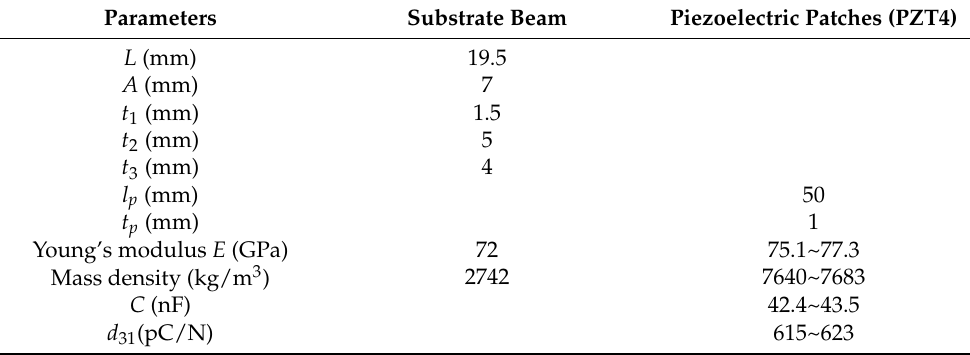
Table 1. Dimensions and physical parameters of piezoelectric bricks.